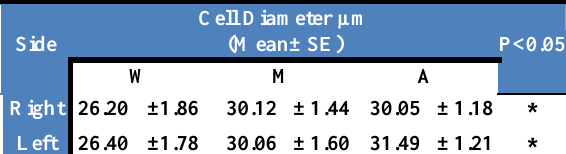
Table, 4: Number of sensory neurons diameter (µm) at level L7 segment of rabbits spinal cord.